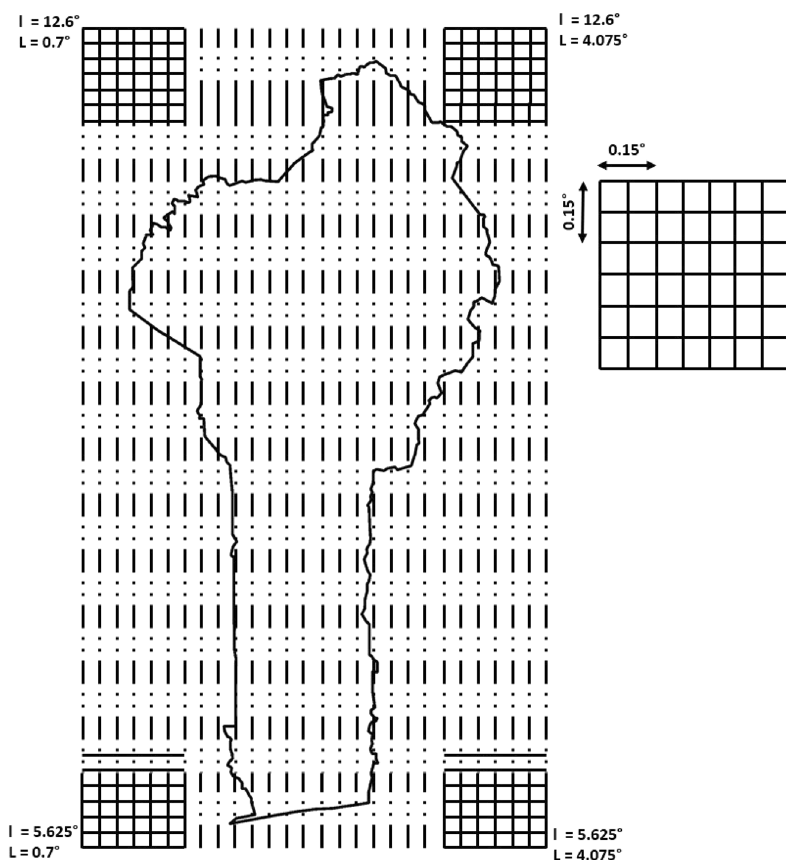
Fig. 10 Benin map (study area)